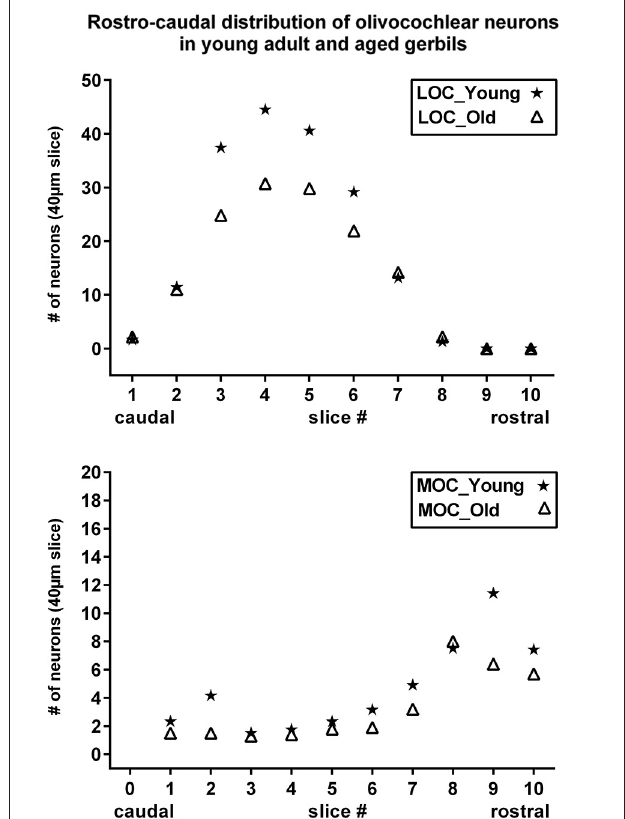
FIGURE 5 | Rostrocaudal distribution of olivocochlear neurons in young adult and aged gerbils . Number of LOC (upper) and MOC (lower) neurons are shown as a function of rostrocaudal location in the SOC. The slice numbers (abscissa) refer to the slices in Figure 1 , and the values for young adult and aged animals are represented as stars and triangles, respectively. Values give the mean number of neurons in the respective slice of 40 µ m thickness as counted in all five animals of each